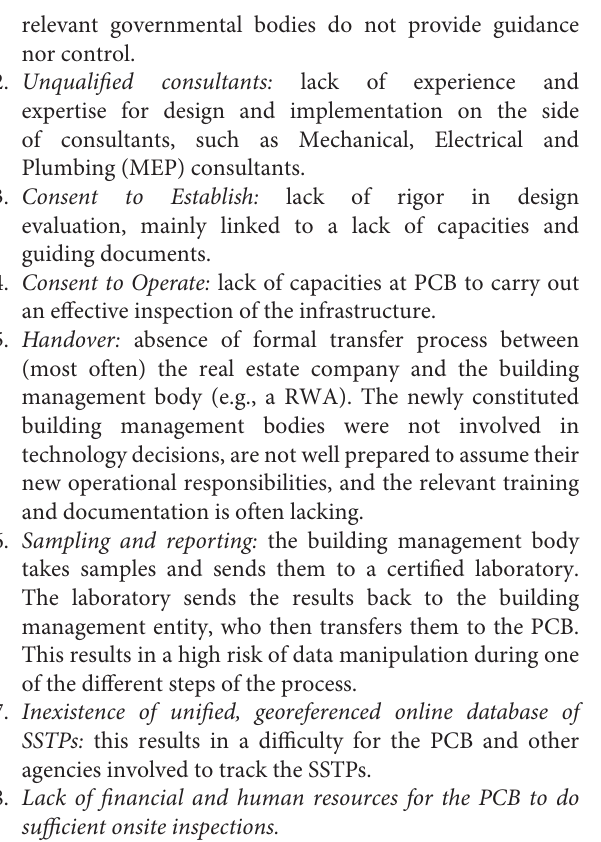
relevant governmental bodies do not provide